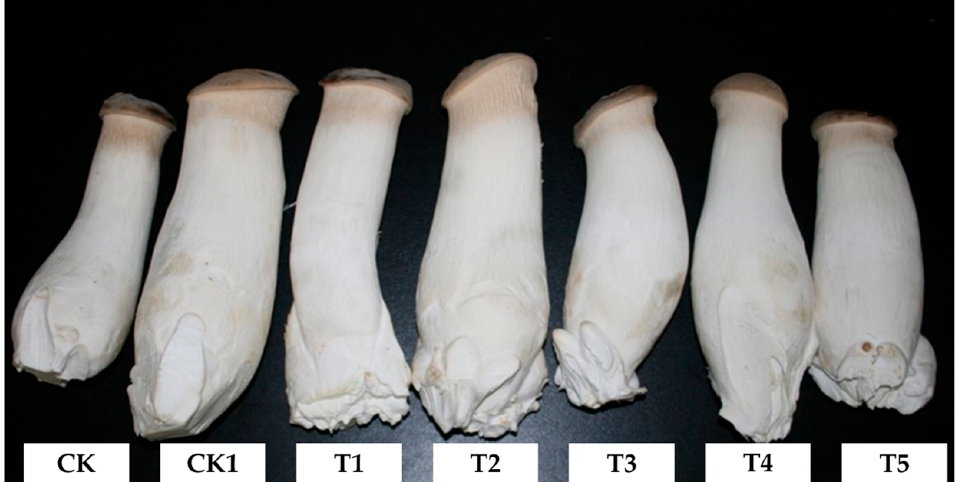
Figure 1. Morphological characteristics of P. eryngii fruiting bodies from mycelia grown on the different substrates. CK: treatment with sawdust 21%, sugarcane bagasse 21%, cottonseed hull 4.2%, ground corncobs 18.4%, wheat bran 18.4%, maize powder 6.8%, and soybean meal 8.4%; CK1: treatment with CK and 0.5% added CaCO 3 ; T1: treatment with CK and 1% added SSP; T2: treatment with CK and 2% added SSP; T3: treatment with CK and 3% added SSP; T4: treatment with CK and 4% added SSP; T5: treatment with CK and 5% added SSP.